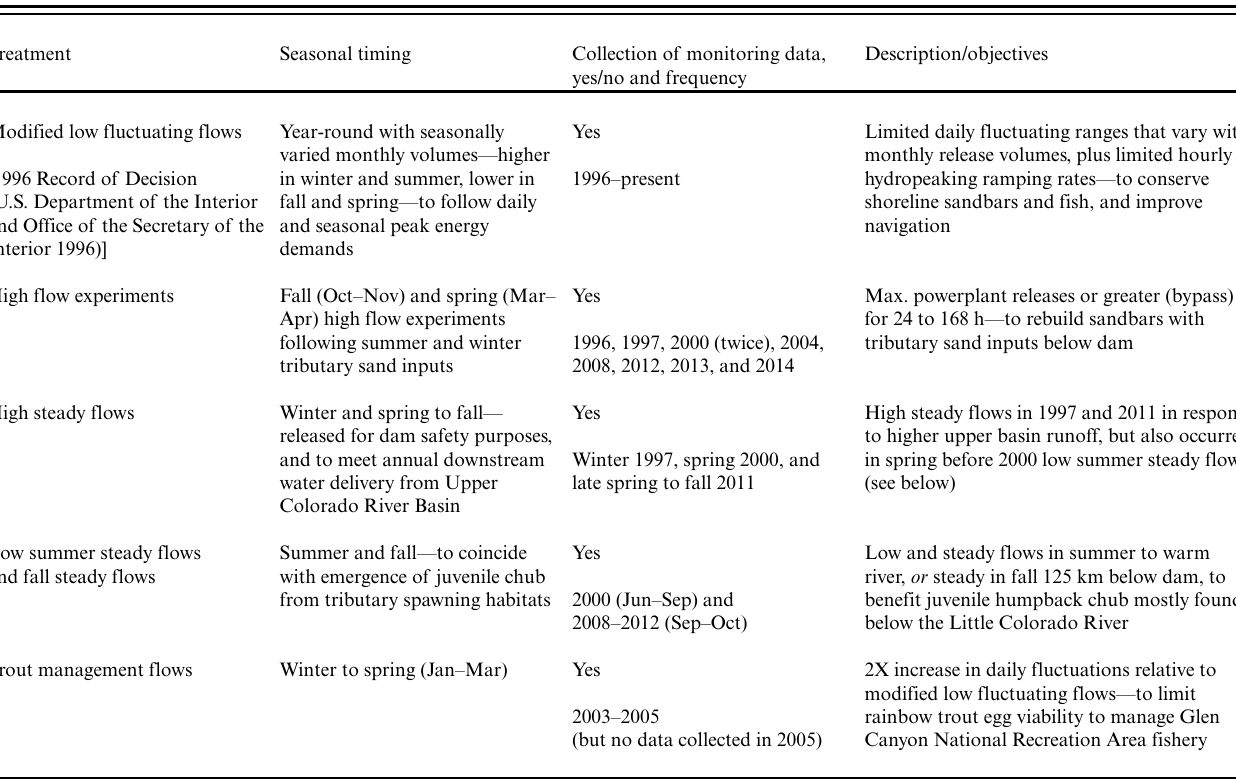
Table 1. Flow experiments monitored in the Colorado River ecosystem below Glen Canyon Dam since 1995.